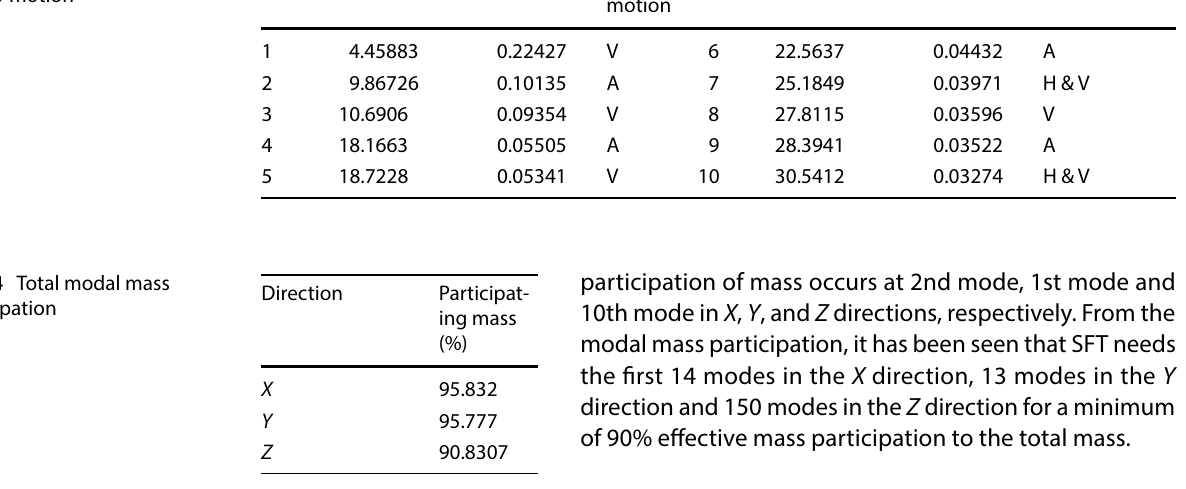
Table 3 Eigenfrequencies and Modes’ motion